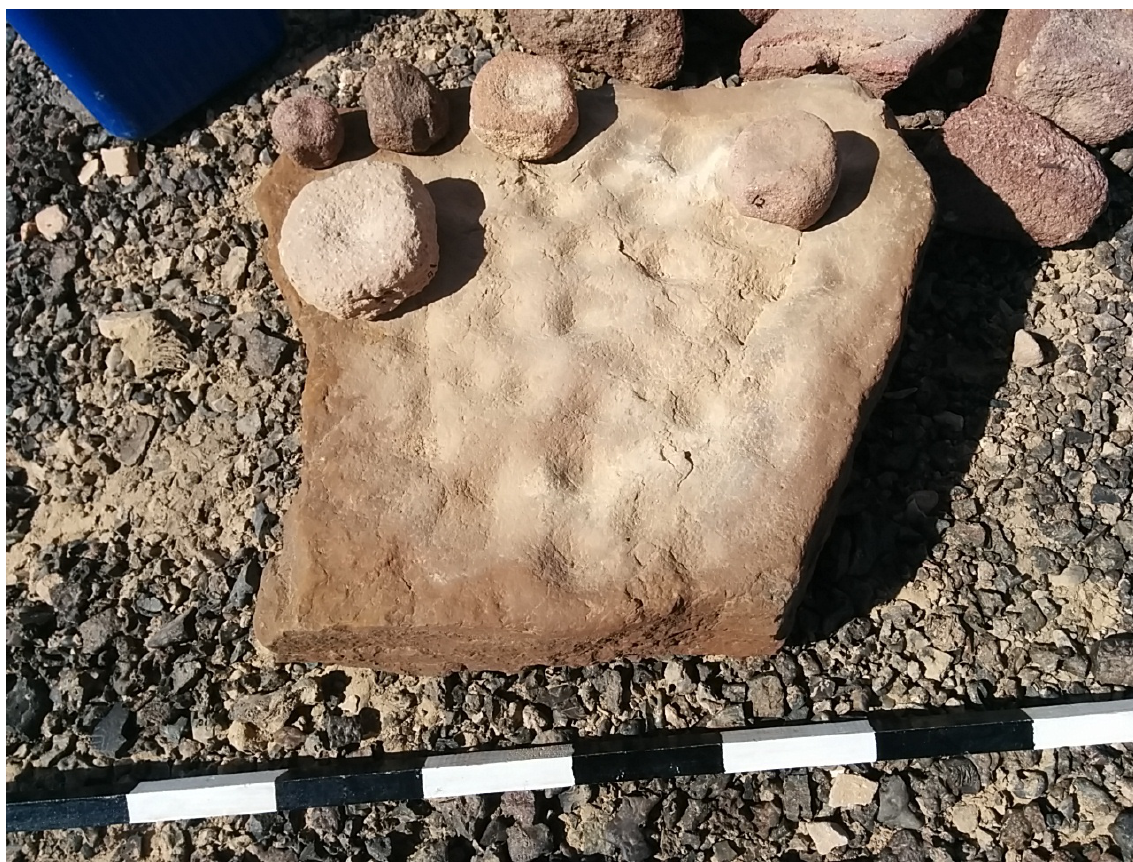
Figure 27. A modern reconstruction of the slag crushing method using ground stone tools which were collected from Site 34 surface survey (conducted in Feb. ’15). The small dimpled pounders are situated on top of the anvil with multiple cup